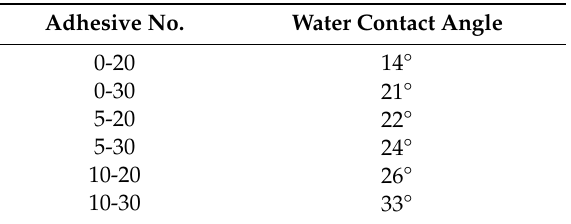
Table 5. Water contact angle of starch-lignin adhesive films.